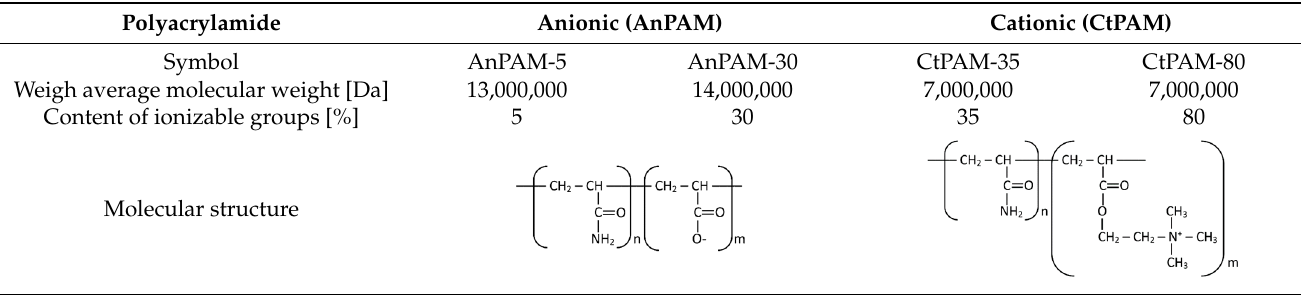
Table 2. Characteristics of examined polyacrylamides.